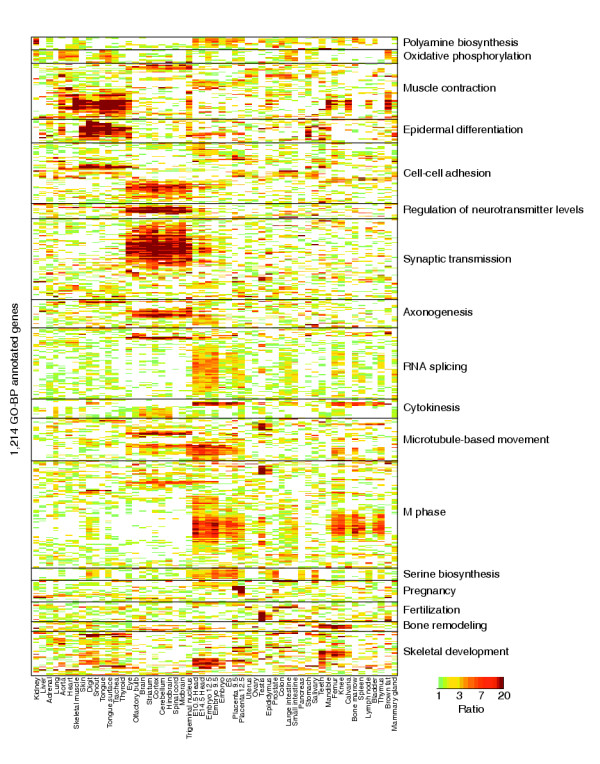
Expression of genes in 17 different functional categories. The categories were ordered manually. The genes within each category were clustered separately from those in other categories. The order of tissues is preserved from previous figures.